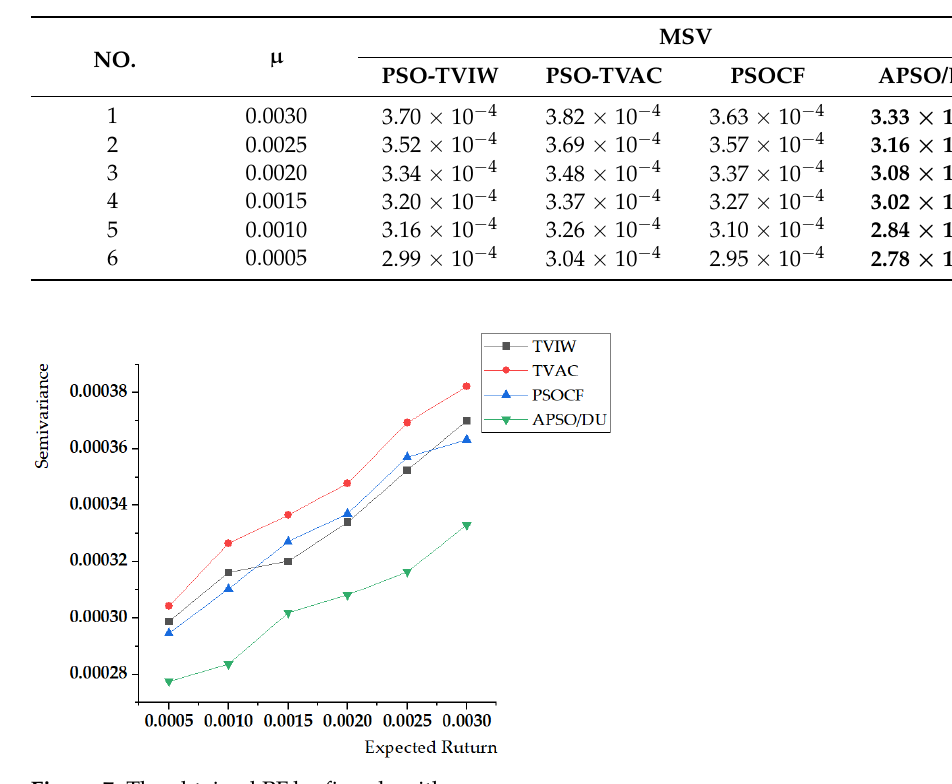
Table 5. Experimental results of five algorithms.